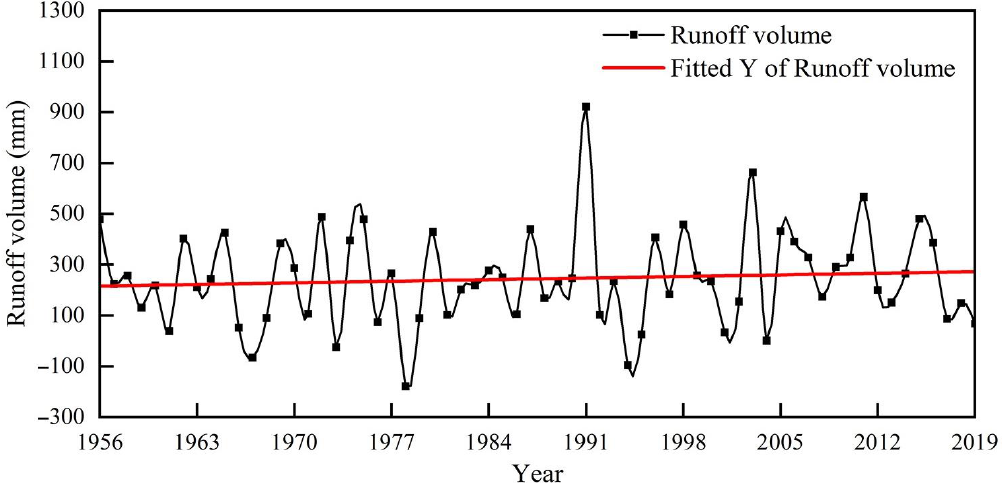
Figure 6. Changes in natural runoff from 1956 to